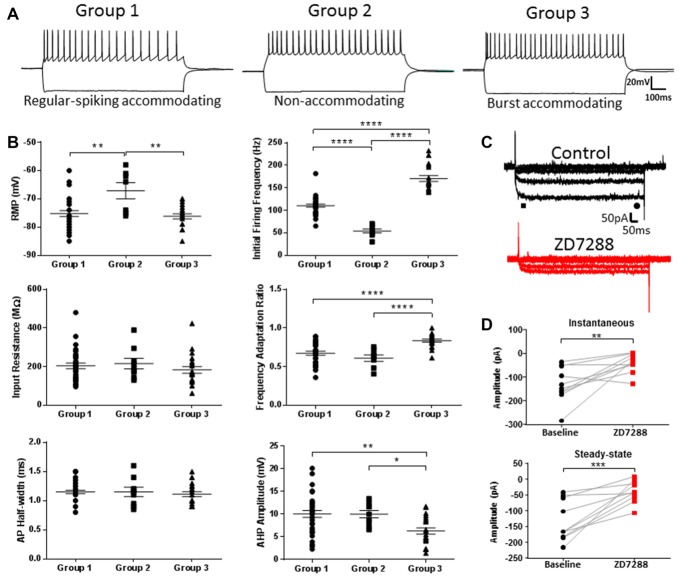
Characterization of identified L1 IN populations. (A) Representative examples of the firing patterns observed for each of the cell groups shown in Figure 1. (B) Quantitative comparison of intrinsic properties in the cell groups including initial firing frequency and frequency adaptation, consistent with PLS-EDA results. (C) Example traces of hyperpolarization-activated current (Ih) recordings before (black, top) and after (red, bottom) wash-on of 20 μM ZD7288. Instantaneous and steady-state currents were measured at the peak after current onset and immediately prior to current offset, as indicated by the black bar and circle, respectively. (D) Plots showing peak instaneous and steady state current amplitudes before and after ZD7288. Hyperpolarization-activated, cyclic nucleotide-gated, non-specific cation (HCN) channel inhibition produced a decrease in both currents indicative of the presence of a small amplitude Ih current in L1 INs. *p < 0.05, **p < 0.01, ***p < 0.001, ****p < 0.0001, Tukey’s post-test. Each shape represents an individual cell. Error bars are mean ± SEM.